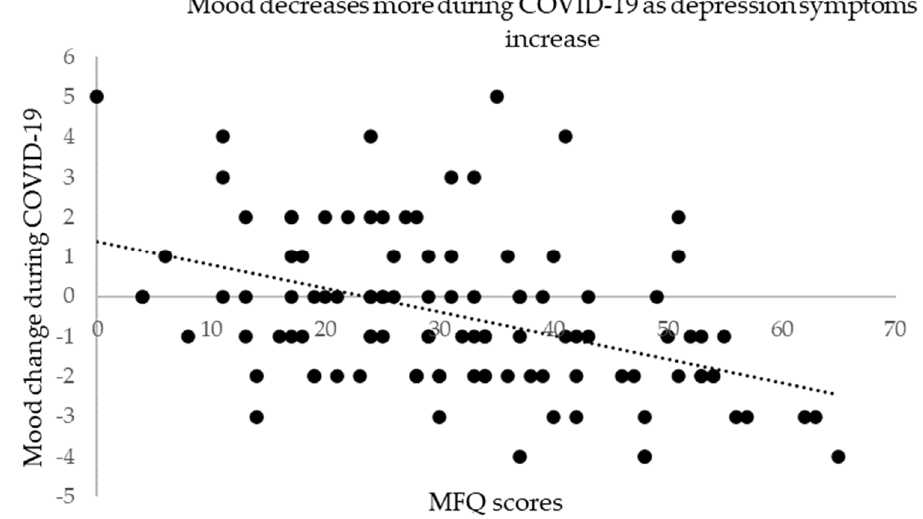
Figure 3. Correlation between MFQ and mood change during COVID-19